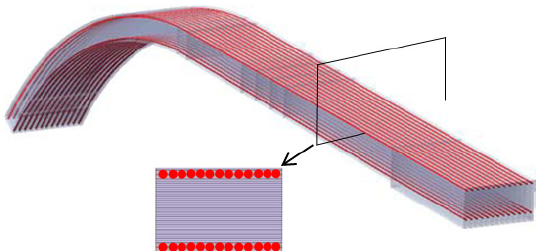
Figure 2: Lateral horn made from a GFRP laminated composite with two layers of embedded NiTi